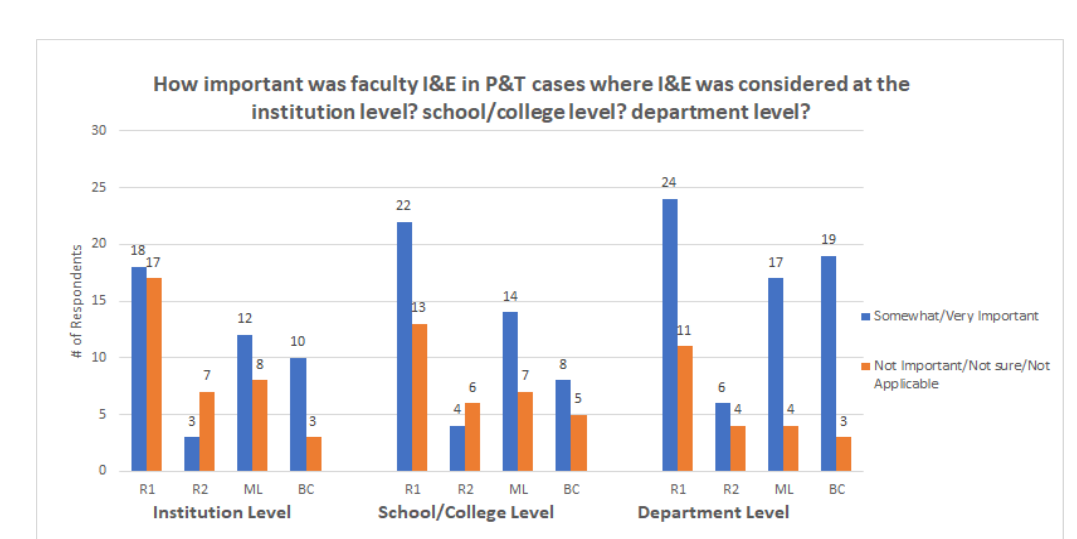
Figure 12. Comparison of I&E considerations in P&T processes across disciplines at respondents’ institutions.